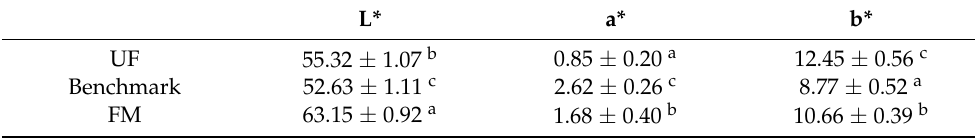
Table 5. Average lightness (L*), redness (a*) and yellowness (b*) values prior to fermentation (UF) and at the end of fermentation by the selected microbial consortia of LAB and yeasts (FM) and by a benchmark bakery yeast (benchmark). Data represent means ± SD. For the same parameter, average values lacking a common letter ( a–c ) significantly differ from each